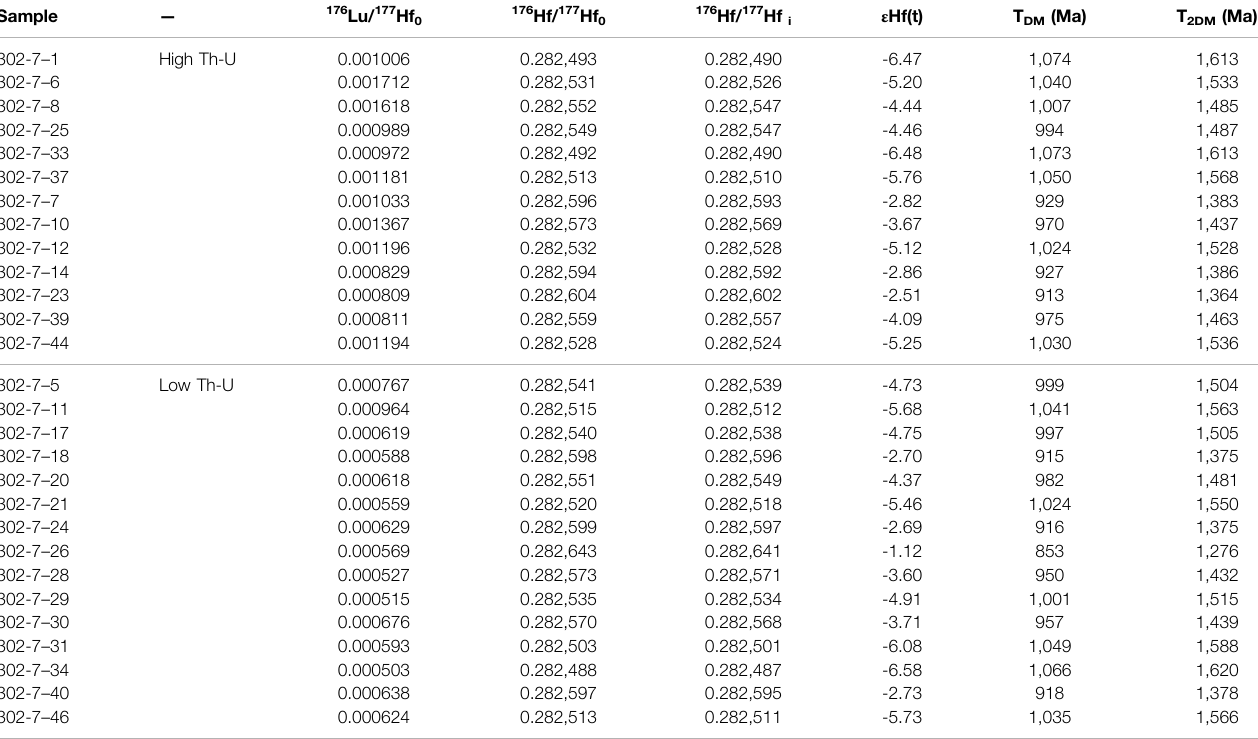
TABLE 3 | Zircon Lu-Hf results of the porphyritic biotite granite from the Jianfengling pluton. Sample